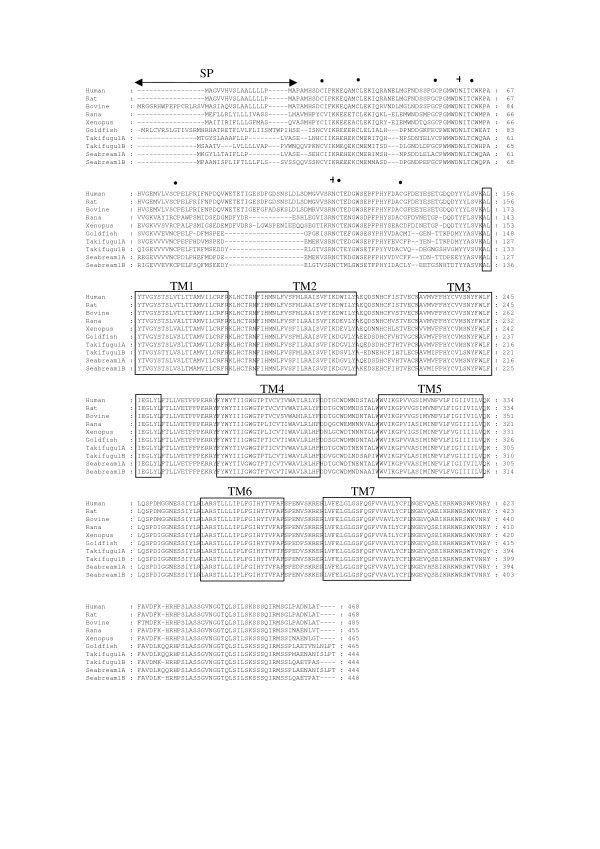
Multiple sequence alignment of vertebrate PAC1 receptors. The seven TM domains are boxed, the P-D-I/M motif indicated by "○"and the R-L-A-R motif by "*". The alternative receptor hop splice isoform is indicated by a dotted box and the putative signal peptide sequence with a double ended arrow. Conserved cysteines and putative N-glycosylation sites in the N-terminal domain are indicated by "●" and "+", respectively. Accession numbers of sequences used in the multiple amino acid sequence alignment were; human (Homo sapiens, P41586), rat (Rattus norvegicus, P32215), bovine (Bos taurus, Q29627), Rana (Rana ridibunda, Q90Y07), Xenopus (Xenopus laevis, Q9PTK1), Goldfish (Carassius auratus, O7376, Takifugu (Takifugu rubripes, AJ494861 for PAC1A and AJ490804 for PAC1B) and sea bream sbPAC1A (AJ514930) and sbPAC1B (AJ514931).